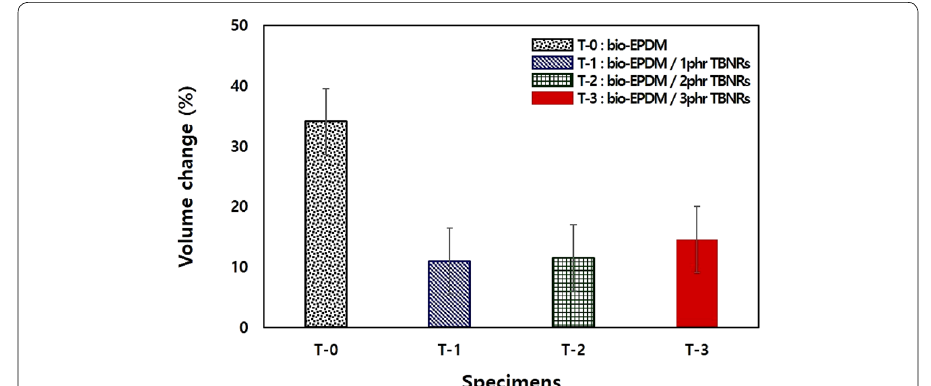
Fig. 5 Volume changes of bio‑EPDM foam with TBNRs after immersed in a 7% NaCl solution for 24 h at 4 °C